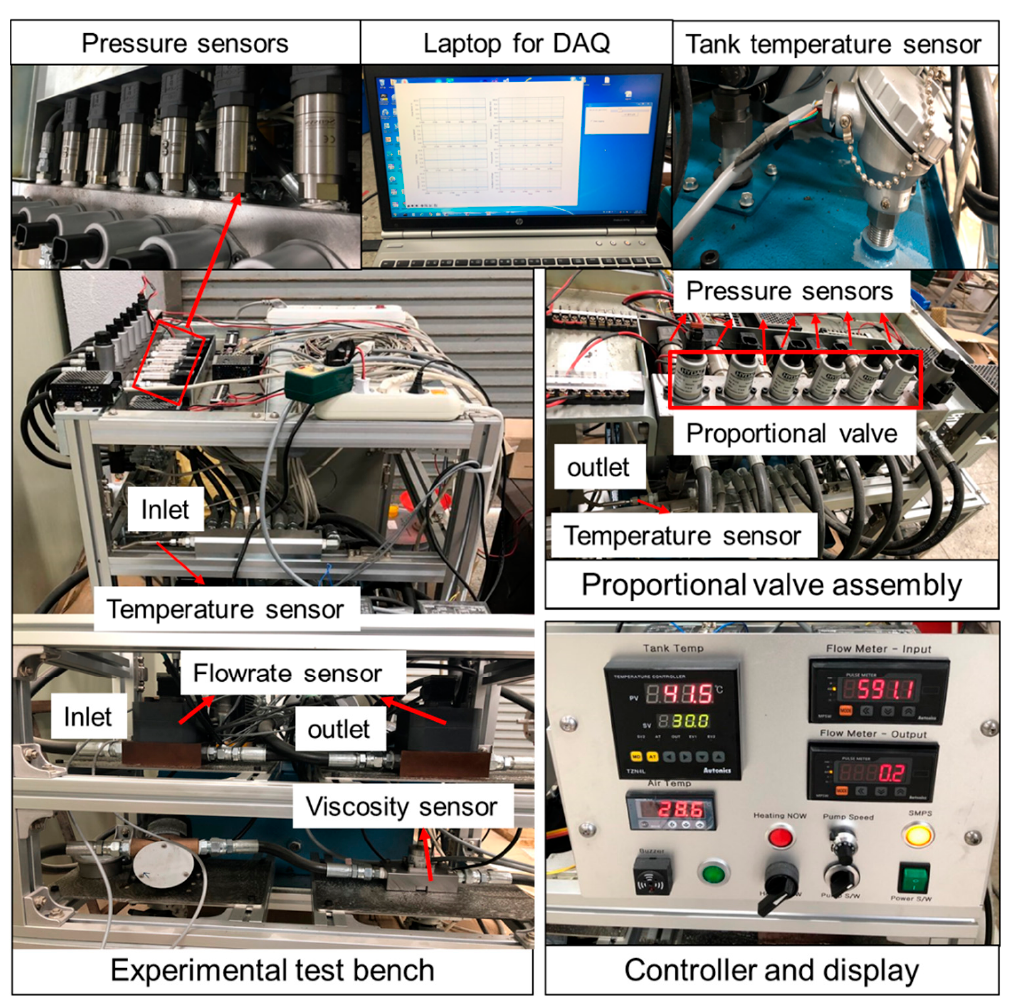
Figure 9. The experimental bench for the proportional valve test.